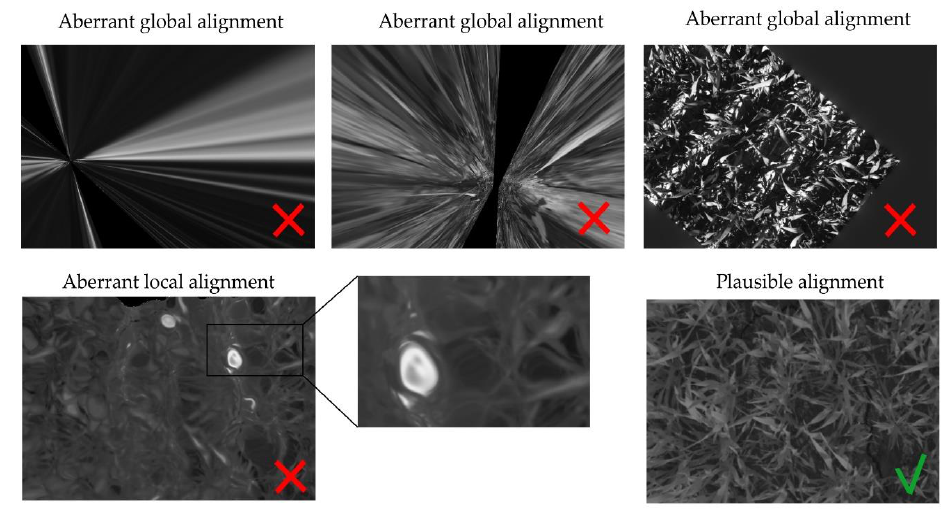
Figure 6. Examples of plausible and aberrant alignments on images from various cameras.